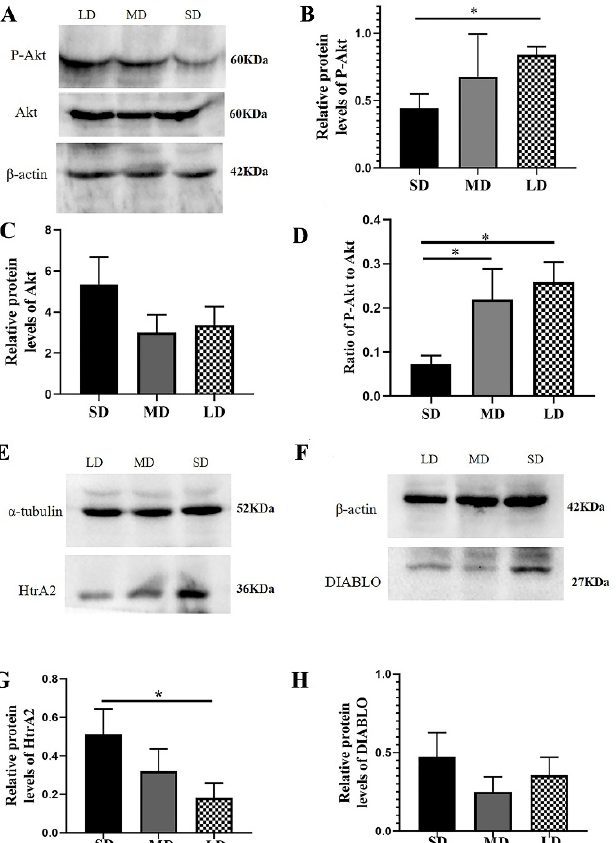
Figure 9. Levels of the PI3K/Akt signal pathway protein expression in the ovaries of Phodopus sungorus under three photoperiod conditions. ( A , E , F ) Representative immunoblots of the key P-Akt, Akt, HtrA2, and DIABLO proteins and internal reference proteins ( β -actin and α -tubulin). ( B , C , G , H ) Relative protein expression of P-Akt, Akt, HtrA2, and DIABLO. ( D ) Ratio of P-Akt to Akt. Values are means ± SEM. n = 8. SD, short daylight; MD, moderate daylight; LD, long daylight. * p < 0.05.